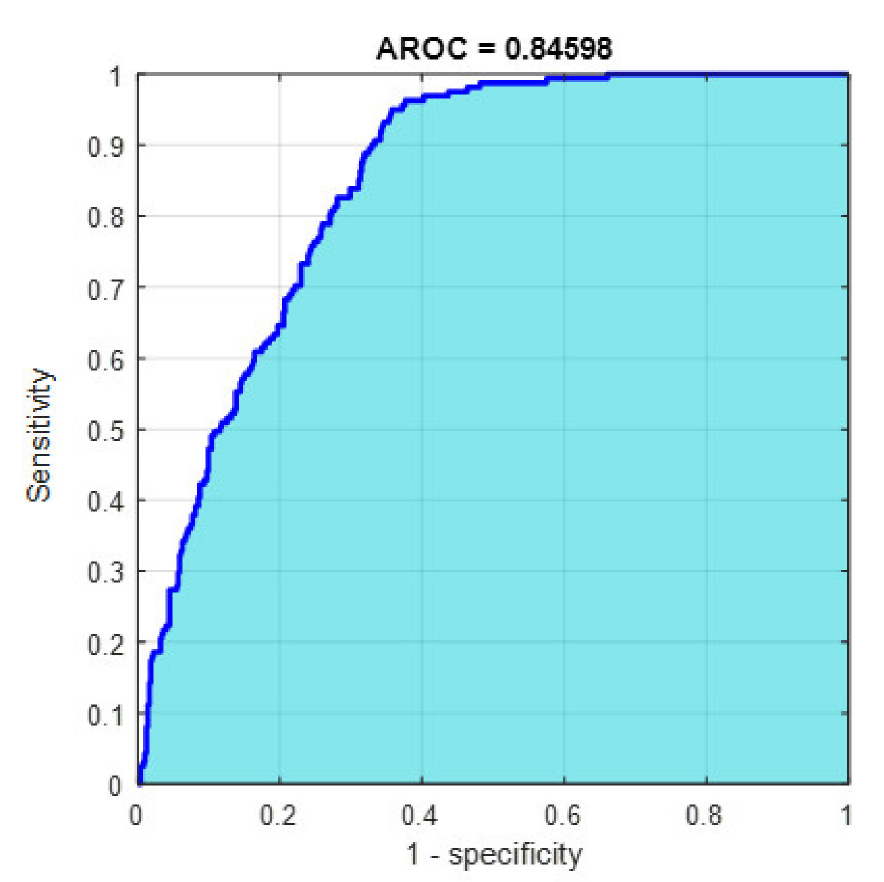
Figure 27. The AROC for grade grading using 1000 deep learning